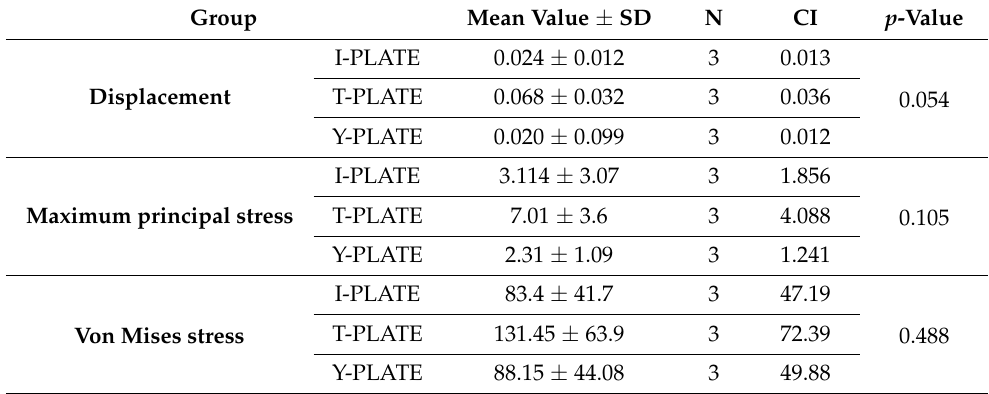
Table 4. ANOVA for the results obtained: standard deviation; CI: confidence interval.